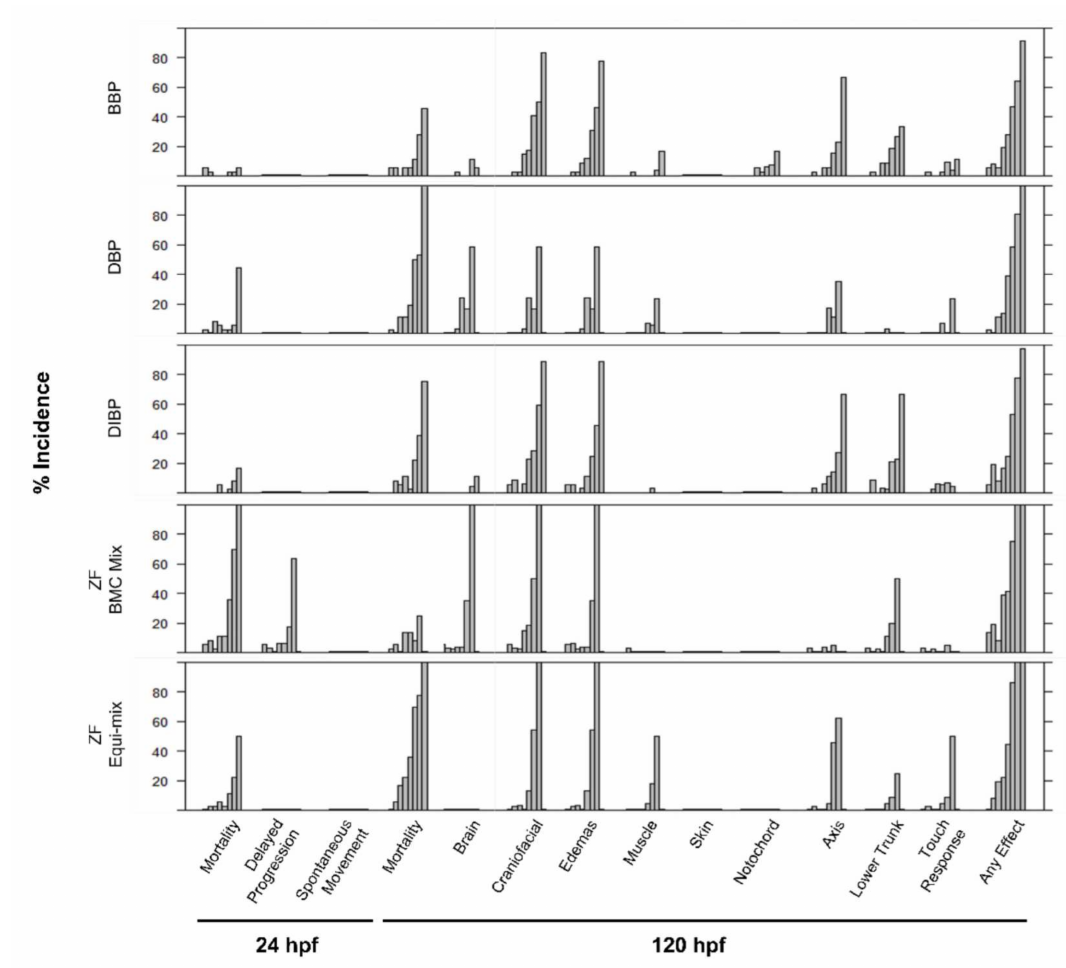
Figure 4. Concentration–response bar plots for incidence of each morphological endpoint from zebrafish bioactivity screening for individual phthalates and equimolar and BMC-based phthalate mixtures. Concentrations across the y -axis for each chemical and mixture are listed in Table